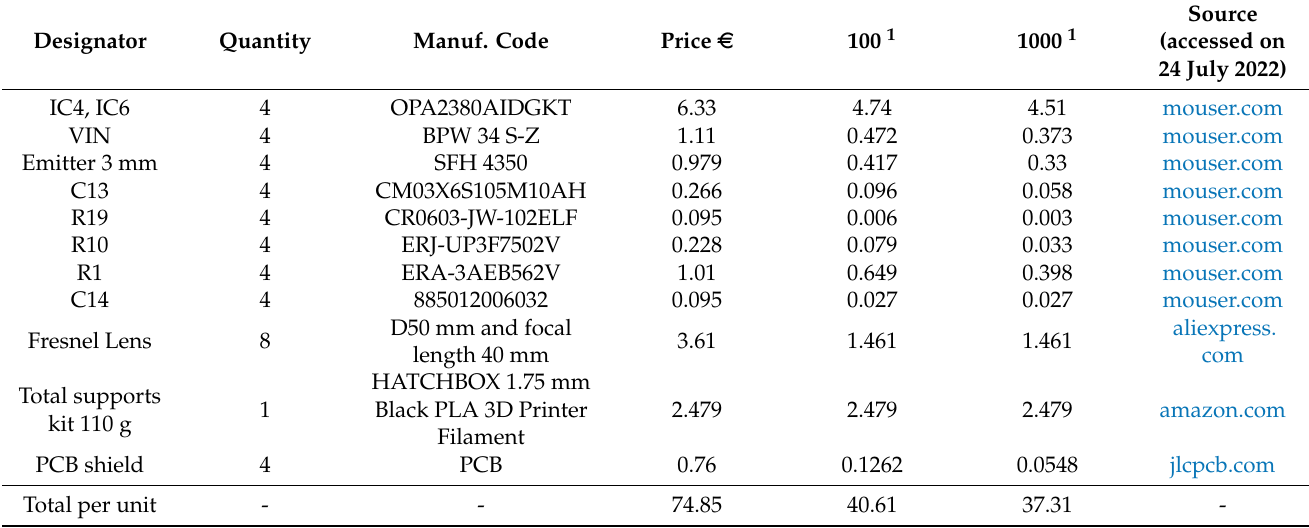
Table 3. Optical sensor bill of materials.